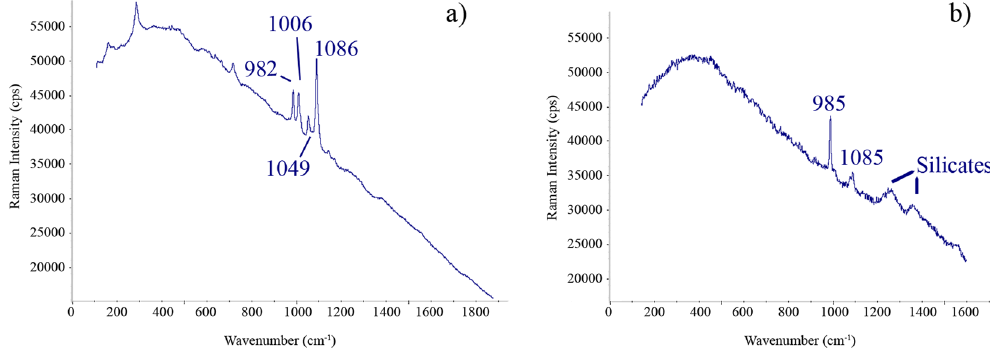
Figure 2. Two Raman spectra collected in the A1 wall of the peristyle in House of Gilded Cupid (Pompeii): ( a ) Calcite (1086 cm − 1 ), syngenite (982 and 1006 cm − 1 ) and niter (1049 cm − 1 ) were identified as a complex mixture,